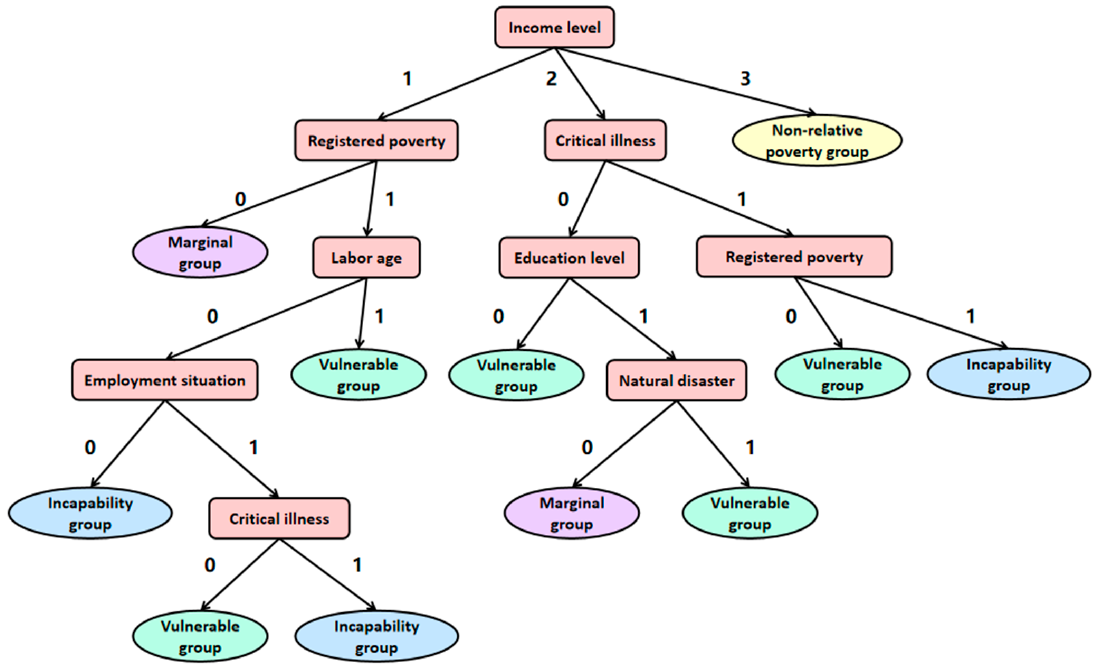
Figure 4. Schematic diagram of relative poverty group evaluation decision tree.